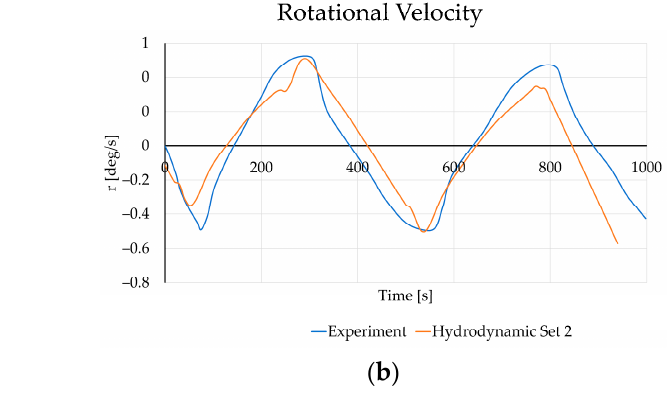
Figure 11. Zigzag 20/20: ( a ) Sway velocity, ( b ) Rotational velocity.